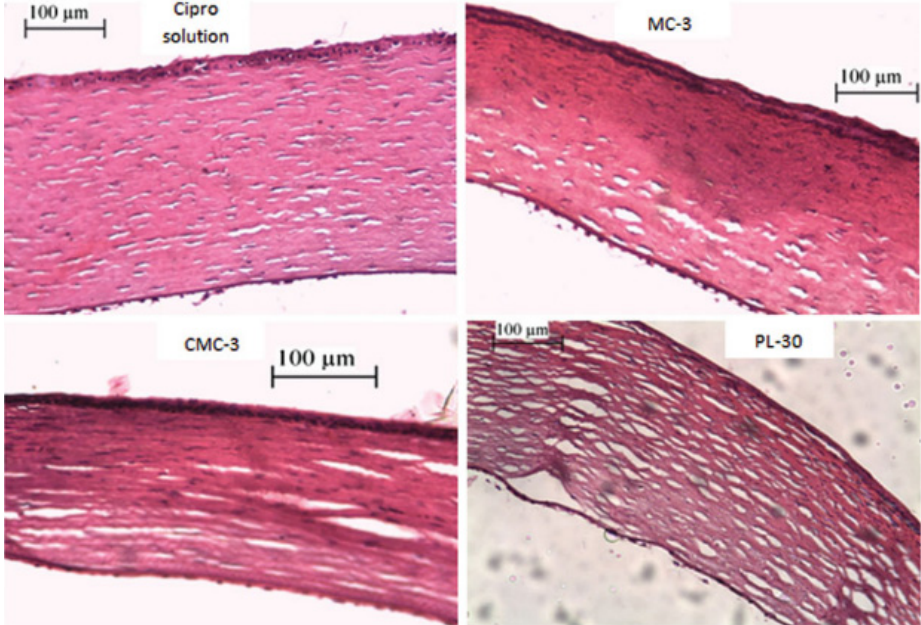
Figure 8. Photomicrographs of corneal after the administration of ciprofloxacin solution, methylcellulose (MC)-based preformed gel, CMC pre-formed gel and Pluronic F-127-based in situ gel [32].